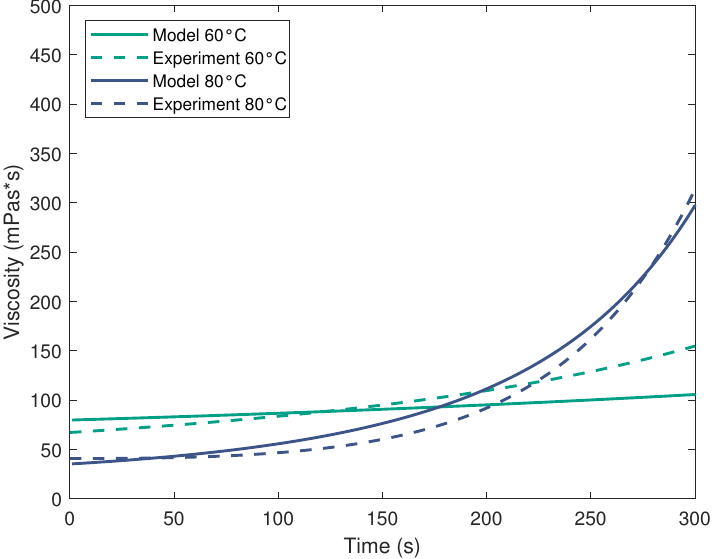
Figure 7. Comparison between viscosity η as a function of time of the Castro-Macosko model and the experimental measurements.